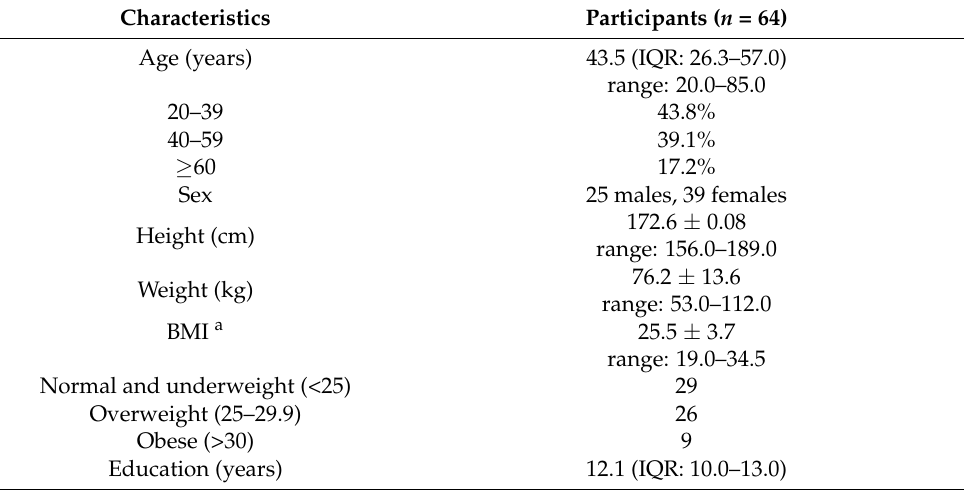
Table 1. Study participant